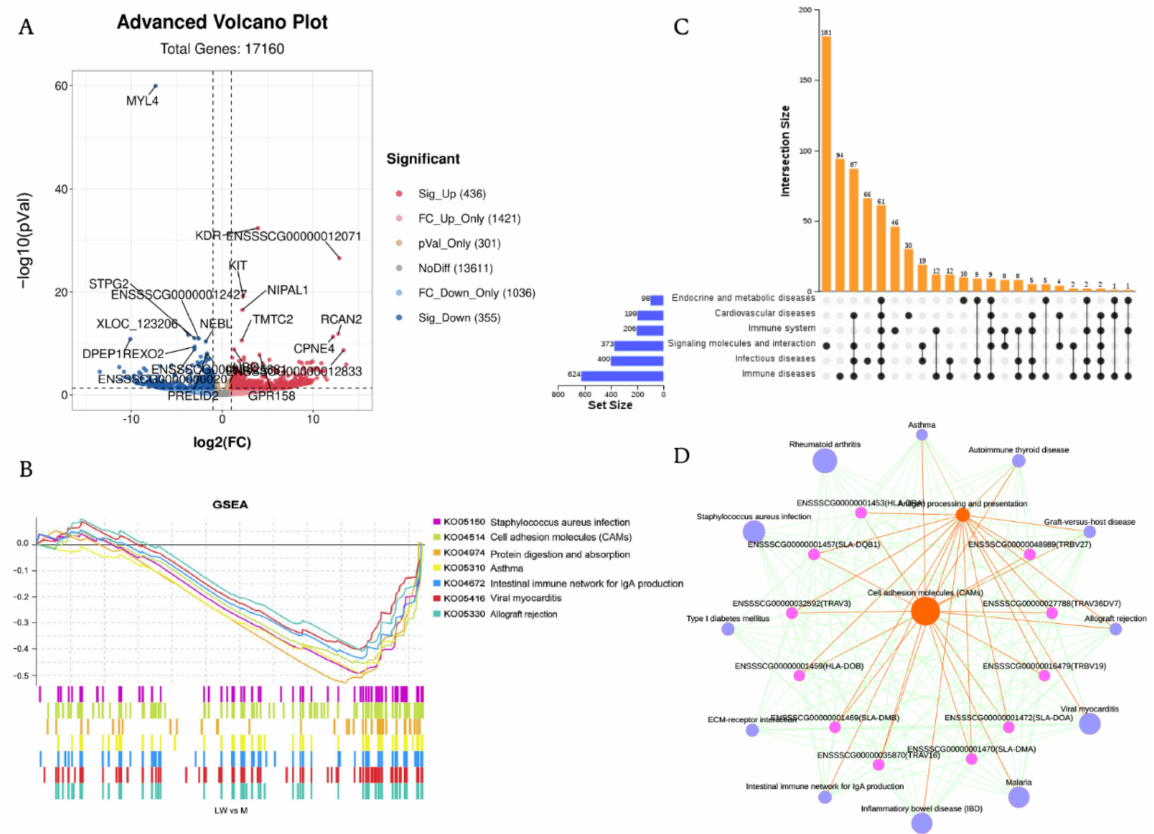
Figure 3. Visualization of transcriptomics results of mRNAs between M and LW in blood serum. ( A ) Volcano plot of all mRNA alterations between M and LW pigs. The horizontal dashed line corre- sponds to p -value < 0.05, and the vertical dashed line corresponds to a 1 − log2 (fold change) (decrease or increase) in expression levels. Red, blue, and gray dots represent upregulated, downregulated, and non-differentially expressed genes in LW pigs (as compared with M pigs). ( B ) GSEA plots partially reveal key pathways within M and LW pigs. Different color squares represent different pathways. p -value ≤ 0.05 and q-value ≤ 0.25 were considered significant. ( C ) Core co-expressed genes in immune and disease-related pathways. ( D ) GSEA significant enrichment pathway and related gene interaction network diagram. The number of genes enriched in the pathway was used to change node